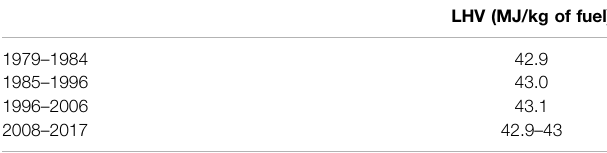
TABLE 1 | Evolution of lower heating value of Diesel fuel (CBS,